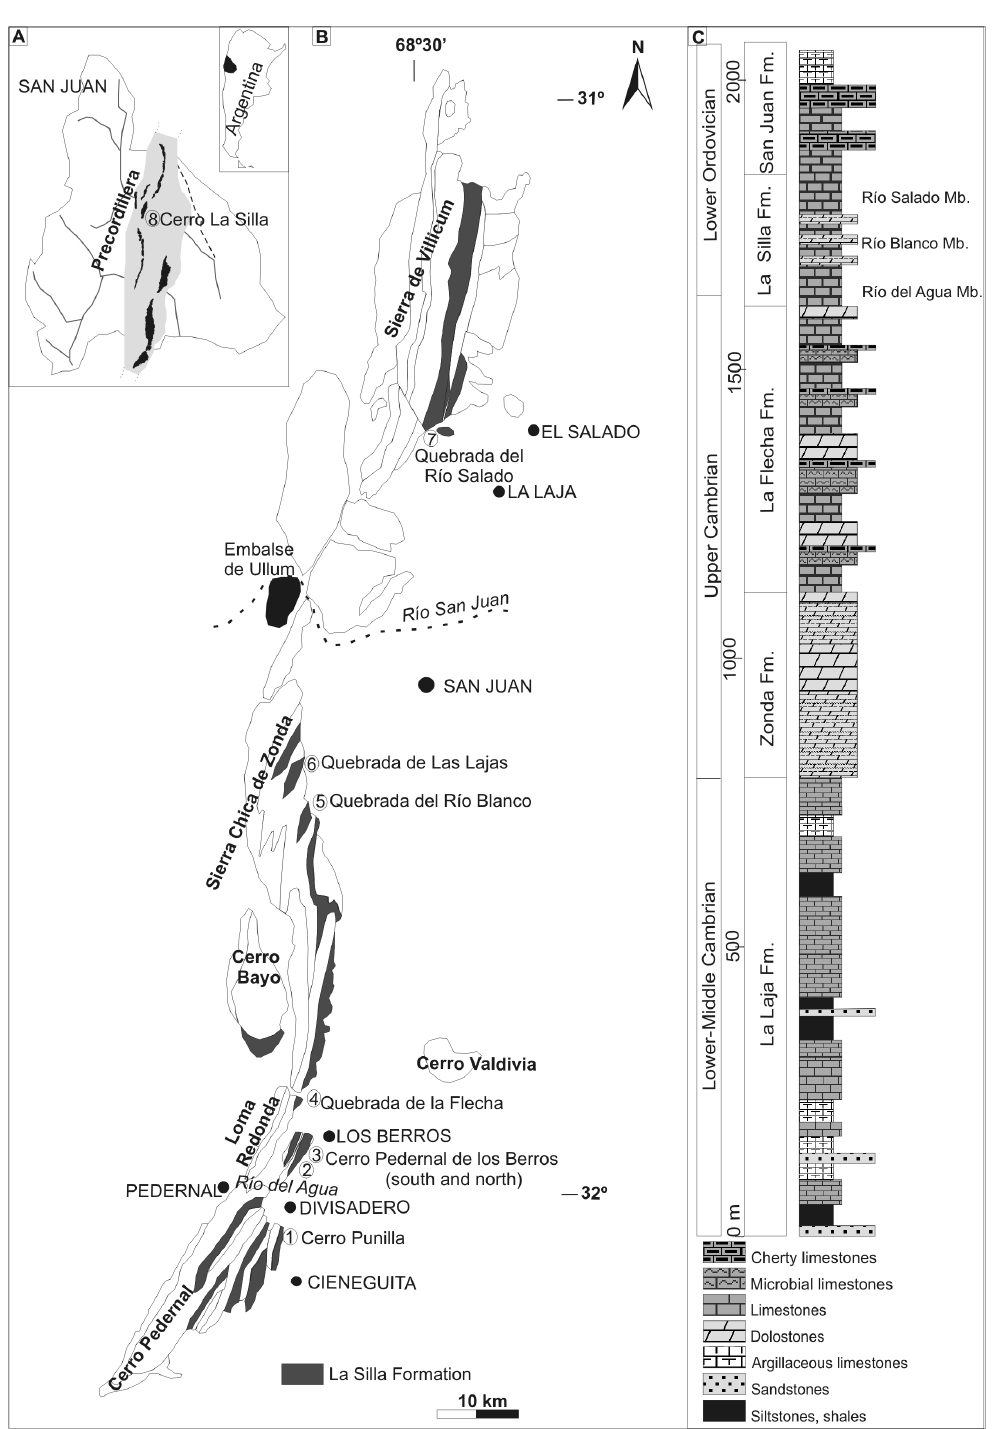
Fig. 1 – Study area in western Argentina. A – Map of the province of San Juan showing the location of the Precordillera terrane and the type section of the La Silla Formation (8). B – Map of the eastern Precordillera in the vicinity of San Juan showing the distribution of the La Silla Formation in its southern sector, and the location of the measured sections (1–8). C – Cambro-Ordovician stratigraphy of the Precordillera in the vicinity of San